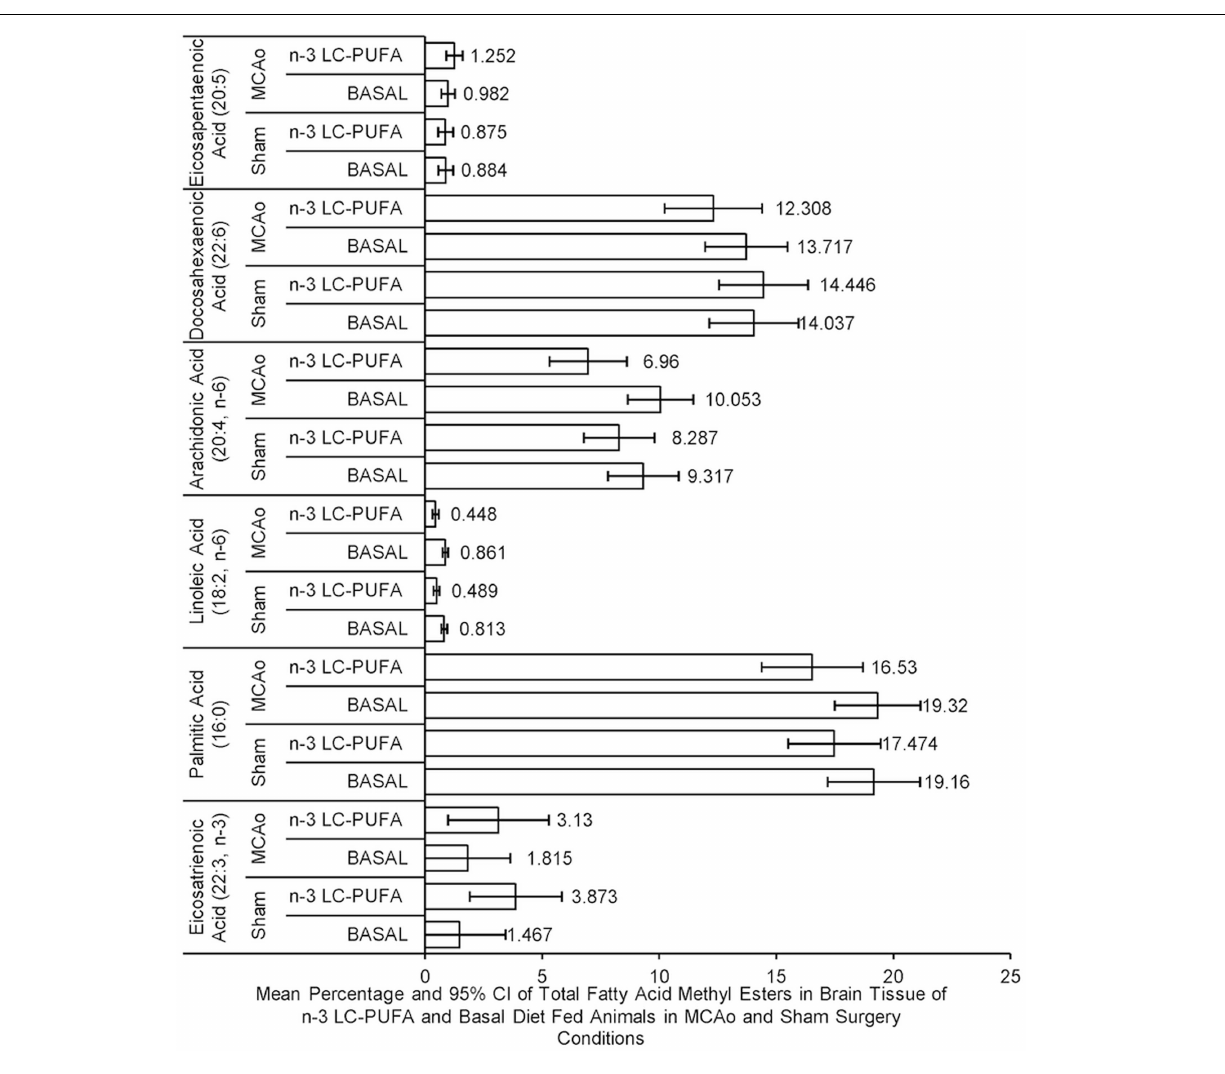
FIGURE 4 | Mean percentage and confidence intervals of whole brain phospholipid fatty acids in fatty acid methyl esters between diet and surgery conditions . Note that although no difference between dietary conditions is seen in the level of eicosapentaenoic acid (20:5) or docosahexaenoic acid (22:6), the levels of fatty acids (palmitic acid [16:0], arachidonic acid [20:4], and linoleic acid [18.2]) were higher in basal diet fed animals, compared to n -3-LC-PUFA fed animals, in whole brain tissue. By comparison, n -3-LC-PUFA fed animals are shown to express more omega-3 derived fatty acids [eicosatrienoic acid (22:3)] than basal diet fed animals. No